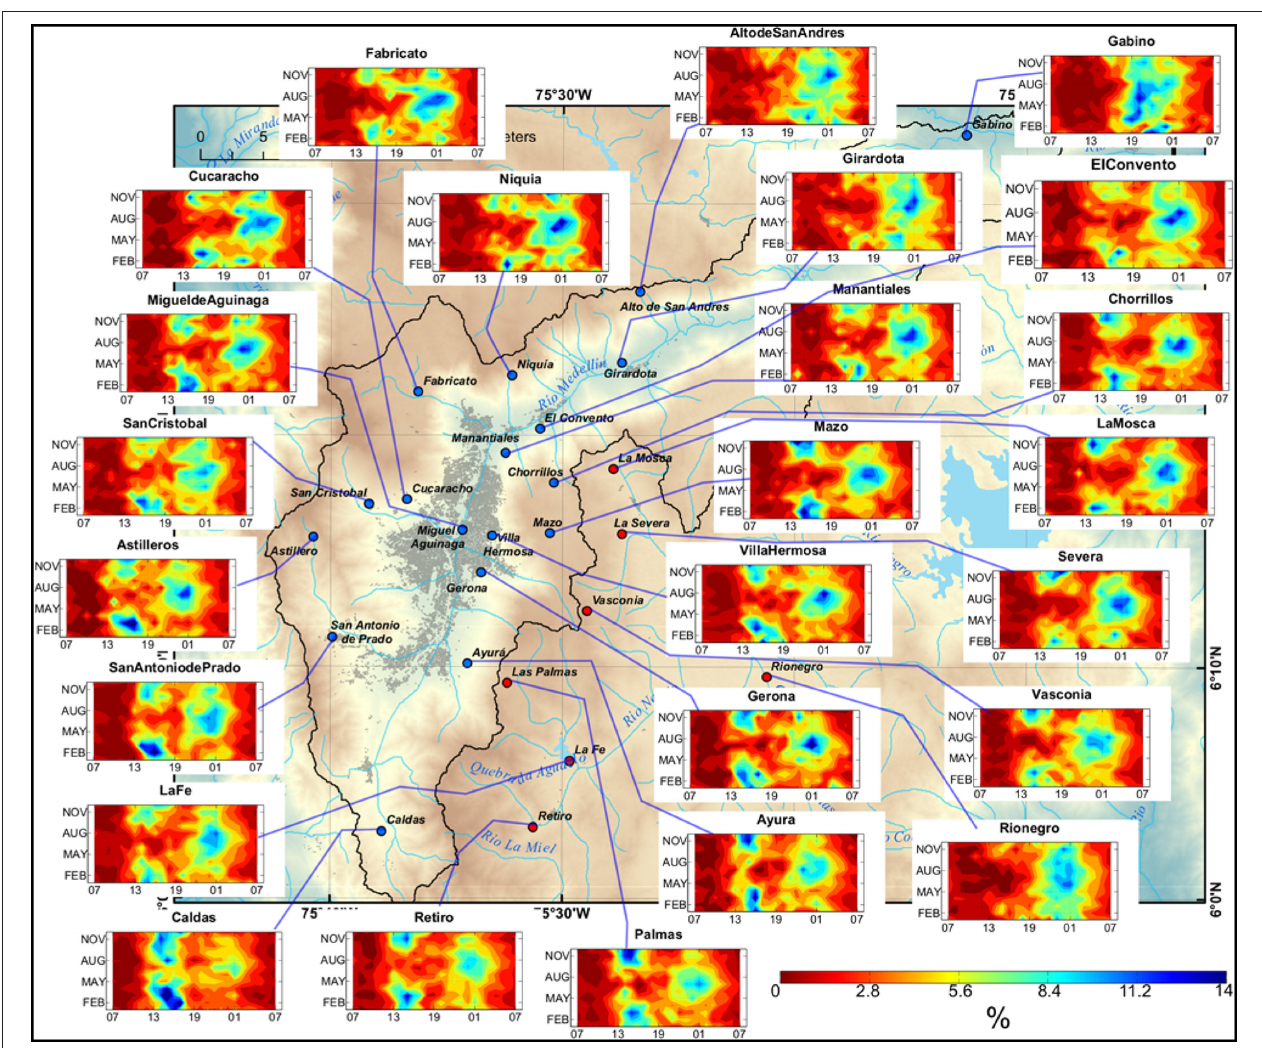
FIGURE 5 | Average diurnal cycle of hourly rainfall through the annual cycle, as a percent of total daily rainfall (Equation 4). Computations based on hourly series including zeros. Blue (Red) points in the map represent the raingauges located on the Aburrá Valley (San Nicolás